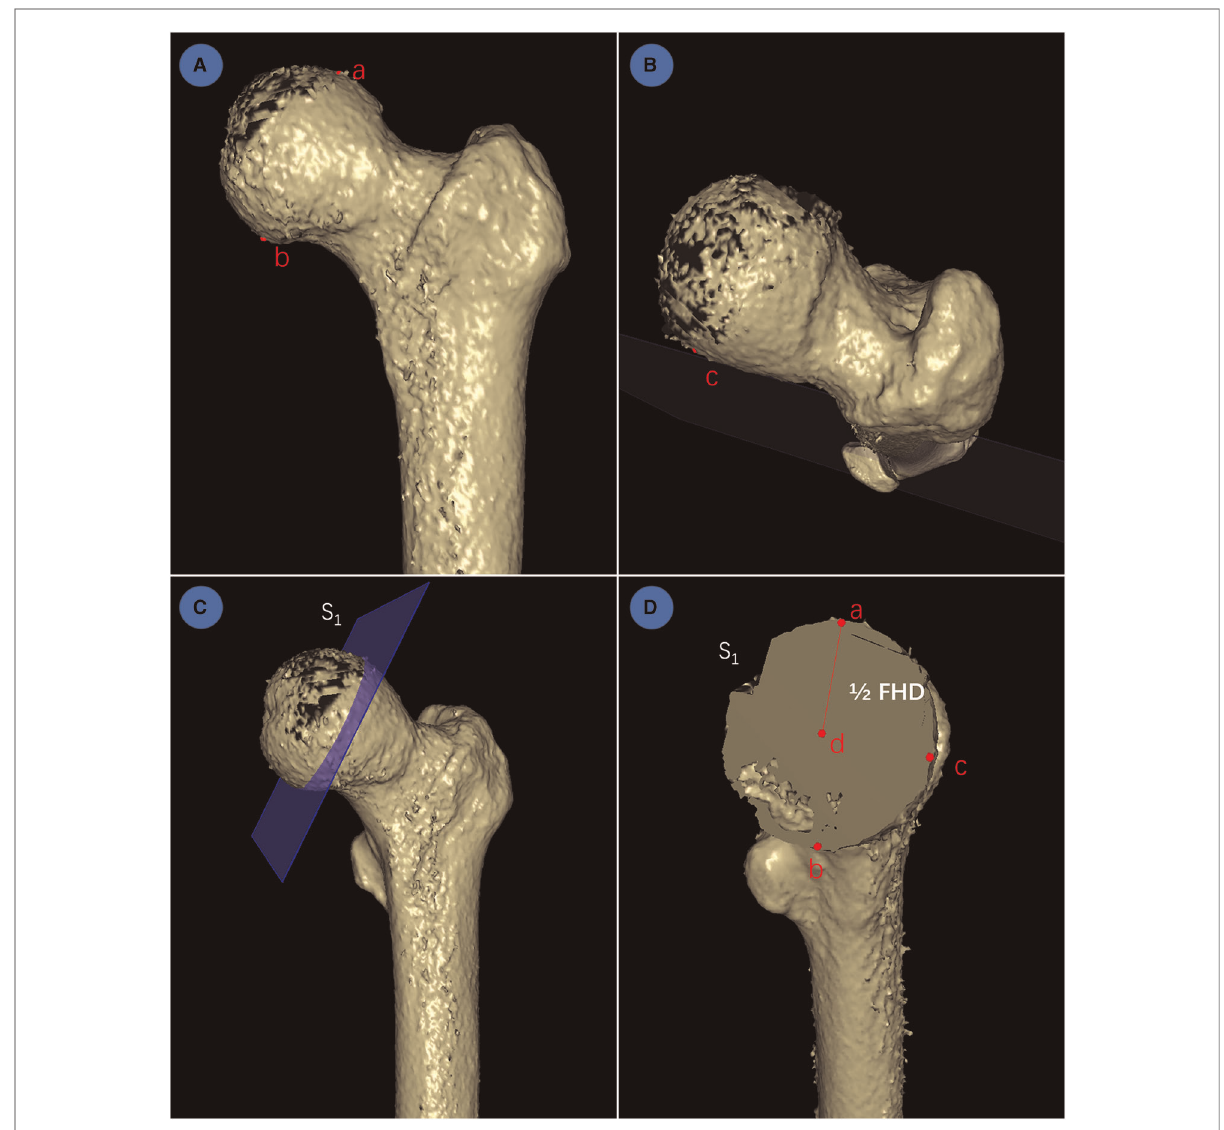
FIGURE 5 Schematic measurement of FHD in 3D space. ( A ) determination of the highest point a and the lowest point b at the maximum expanding region of femoral head at the anterior-posterior view; ( B ) determination of point c at the maximum expanding region of femoral head at the overlook view; ( C ) according to geometry, these three points could determine a plane S 1 ; ( D ) the center point d, radius (line segment ad=1/2 FHD) and diameter (FHD) could also be determined using geometry